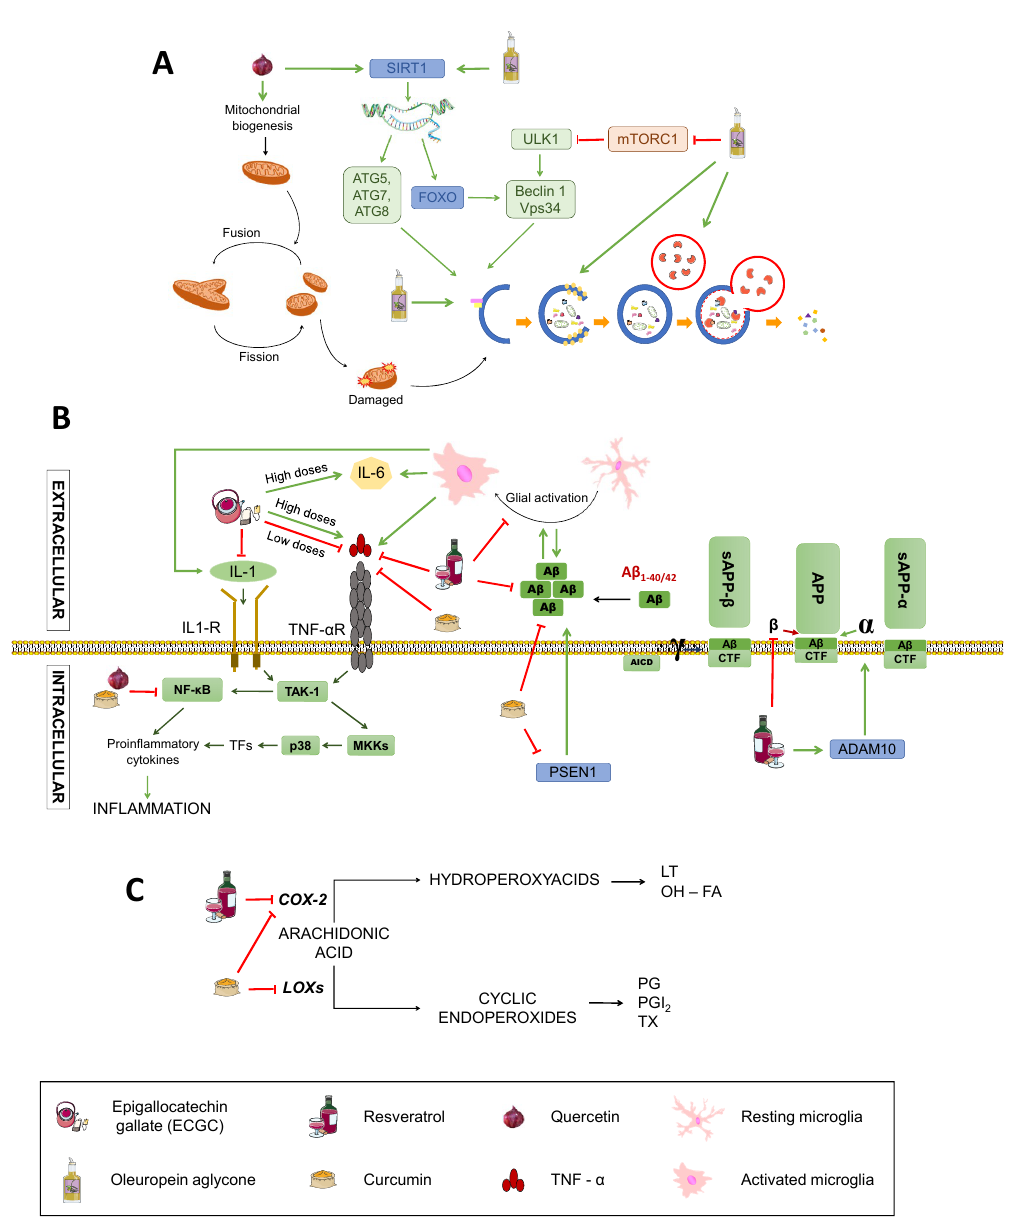
Figure 6. Effects on inflammation signalling pathways and A β production; ( C ) Effects on